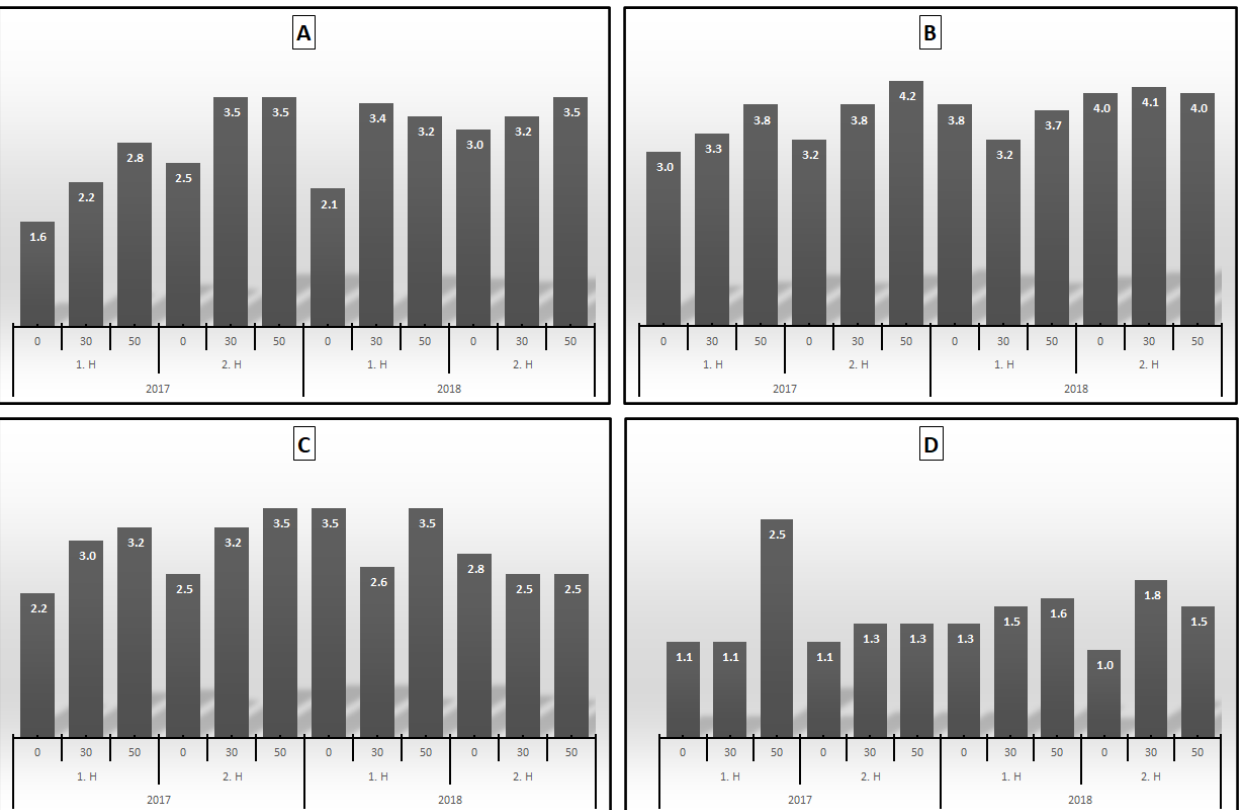
Figure 3. Antimicrobial inhibition zone (mm) of ( A ): Staphylococcus aureus ; ( B ): Enterococcus faecalis; ( C ): Candida albicans ; ( D ): Candida parapisilosis according to HT and HAD in 2017 and 2018.